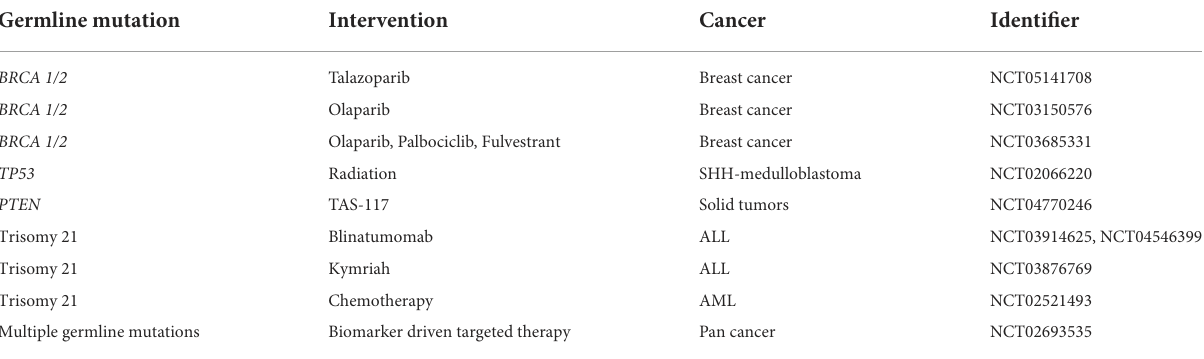
TABLE 5 Interventional clinical trials for cancer treatment specific for patients with germline cancer mutations in the United States.